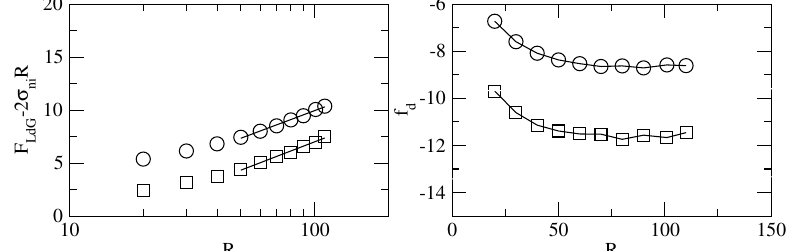
Figure A3. ( Left ) Plot of F LdG / L z − 2 σ sn R as a function of R for interfacial nematic–isotropic configurations with a disclination line of topological charge + 1 (circles) and a disclination line of topological charge − 1 (squares). ( Right ) Plot of f d as a function of R . The meaning of the symbols is the same as in the left